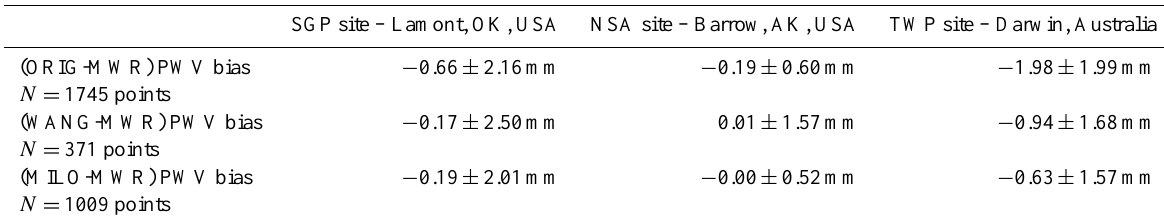
Figure 3. A comparison between the PWV derived from the original radiosonde data (top), WANG-corrected (middle), and MILO-corrected (bottom) radiosonde data with the PWV derived from the collocated MWR at the SGP site (panels a1 , a2 , and a3 ), NSA site (panels b1 , b2 , and b3 ), and TWP Darwin site (panels c1 , c2 , and c3 ). The solid black line superimposed on the data denotes the mean values for each PWV bin, and the vertical lines represent the standard deviations. Table 1. A summary of the microwave radiometer and radiosonde un/corrected PWV biases (in mm) with ± 1 σ uncertainty from the ARM’s SGP, NSA, and TWP (Darwin)